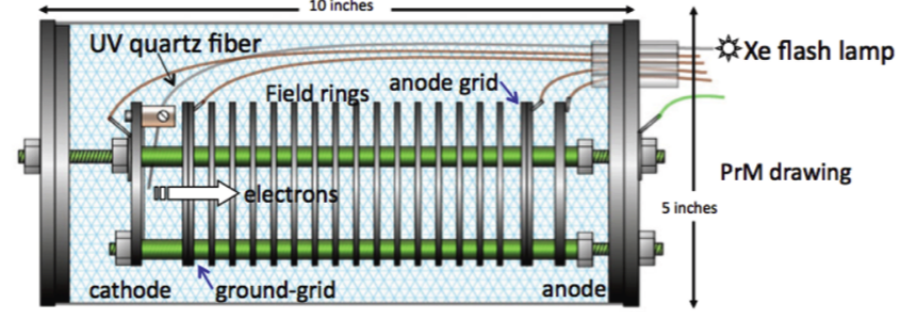
Figure 6. A drawing of a liquid argon purity monitor. This figure is from